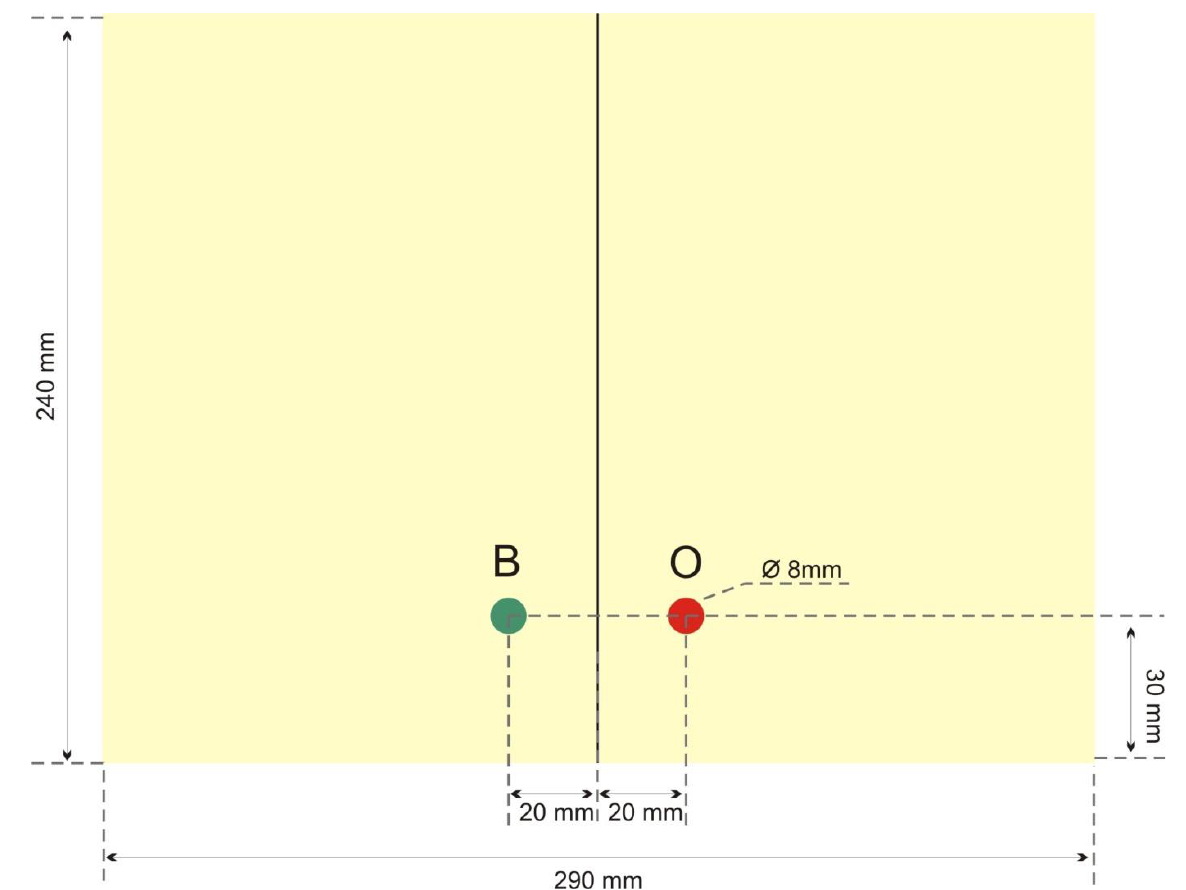
Figure 3. Image detector model, top view. The logical detector under the tumor (O) is marked in red. The logical detector, which was the reference one and located in the background radiation area (B) during the measurement, is marked in green.